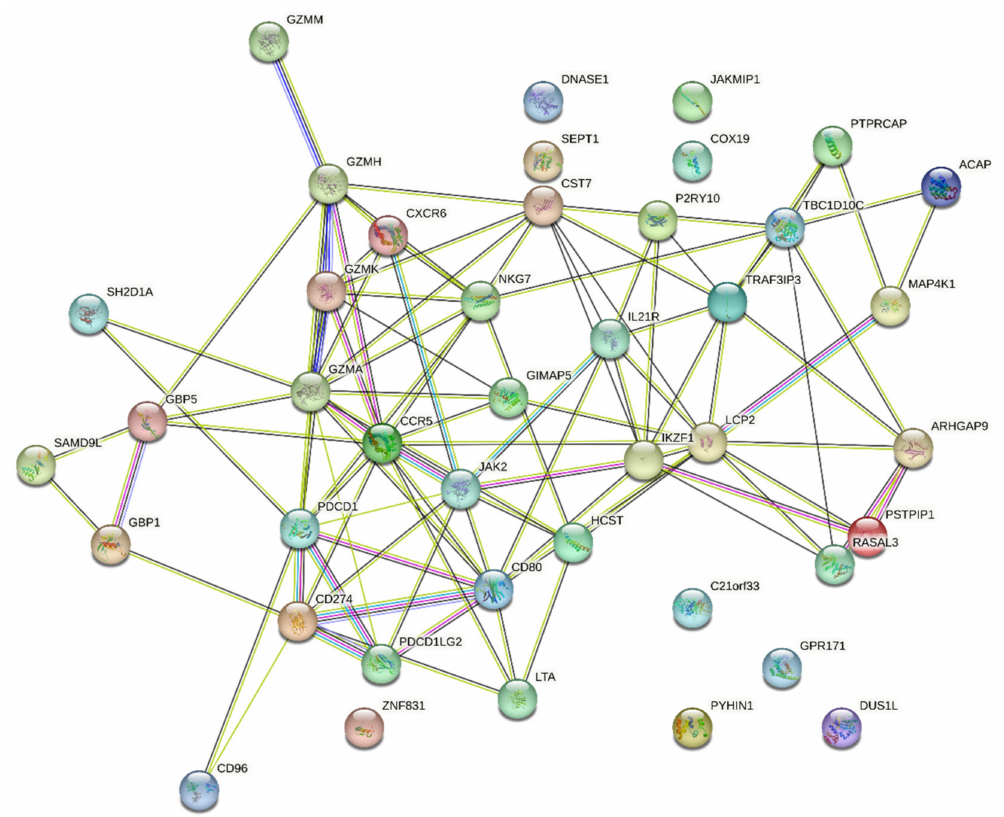
Figure 1. STRING connectivity map of the PDCD1/CD274 network identified in the preceding study. As identified by STRING, the protein–protein interaction (PPI) enrichment p -value was less than 1.0 × 10 − 16